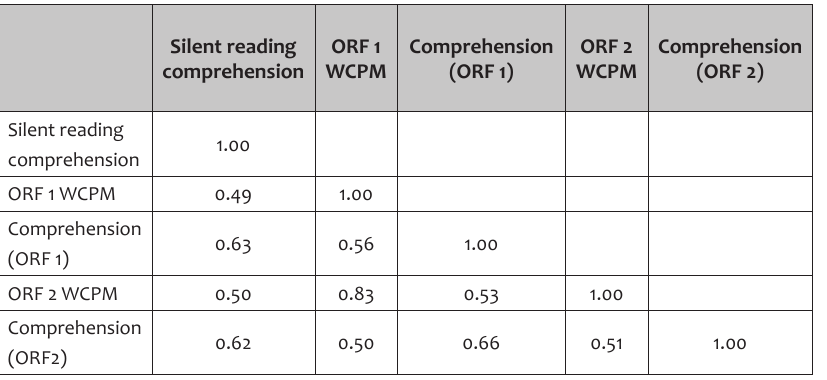
Table 8: Pearson correlations between key